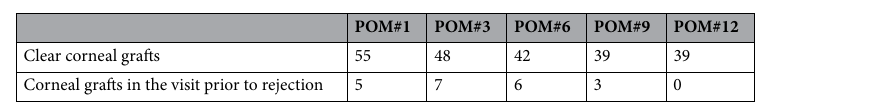
Table 2. Number of analyzed cases at each post-operative month (POM).